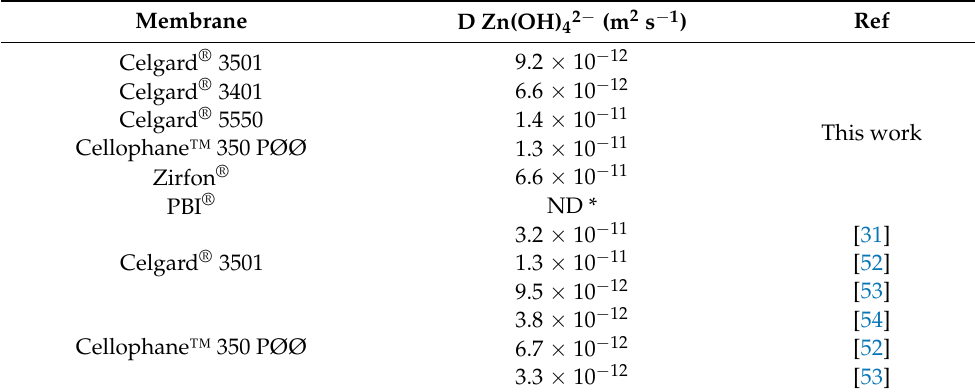
Table 3. Diffusion coefficients of Zn(OH) 42 − ions through the membranes.